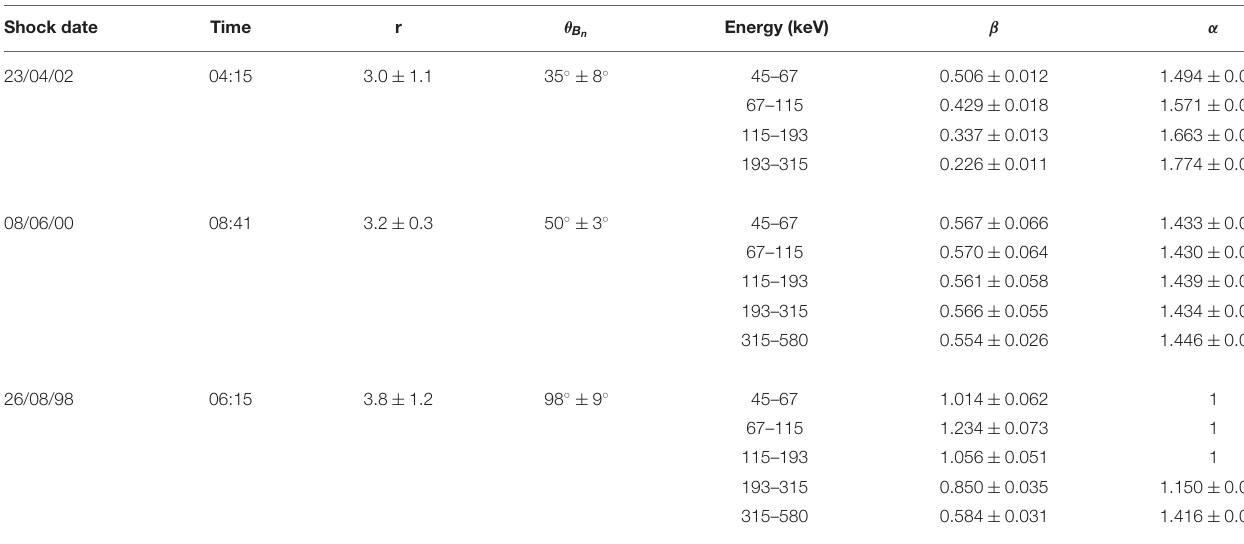
TABLE 1 | Shock parameters and fit